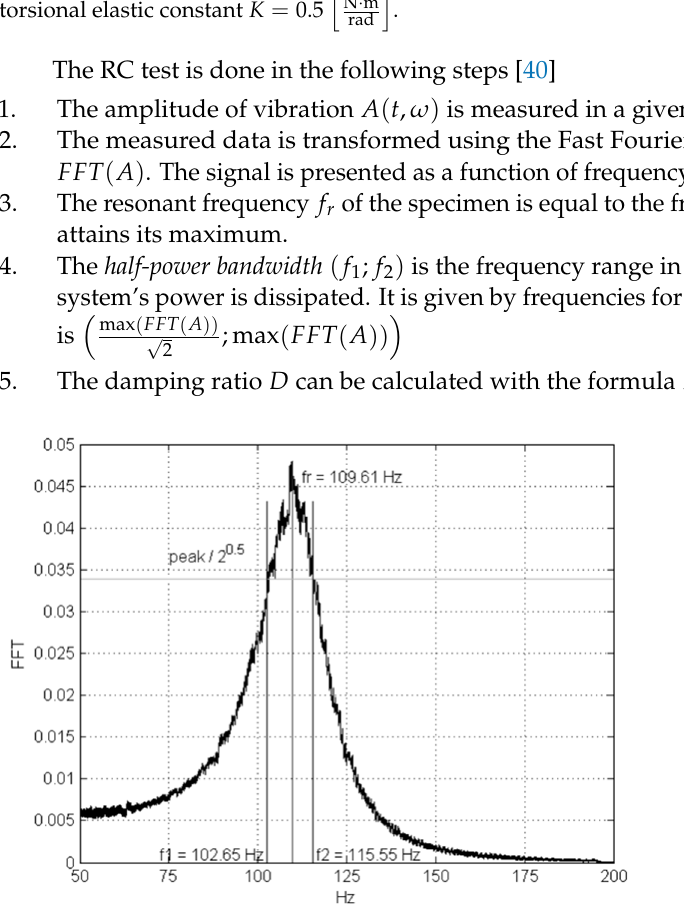
Figure 6. The FFT analysis of RC data (in Figure 5). Identification of the half-power bandwidth. 3. The resonant frequency 𝑓 (cid:3045) of the specimen is equal to the frequency for which 𝐹𝐹𝑇(𝐴) attains its maximum.